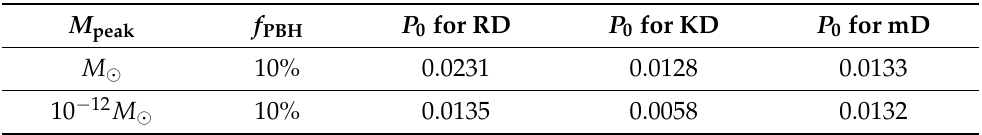
Figure 7. The weighted mass function M ψ ( M ) plotted for the Gaussian and Broken power law power spectra in the left and right panels, respectively. P 0 = 0.02 for w = 1/3 and P 0 = 5 have been used. In the left (right) panel, the blue (green) curve is for w = 0 with T RD = 30 MeV, the cyan (grey) curve is for w = 0 with T RD = 5 MeV, and the red (magenta) curves are for w = 1/3. The solid, dashed and dotted lines signify the cases with M peak = 1, 10 and 0.1 M Table 1. Necessary peak amplitude of GPS to reach 10% PBH abundance for the specific non-standard post-inflationary scenarios discussed in this